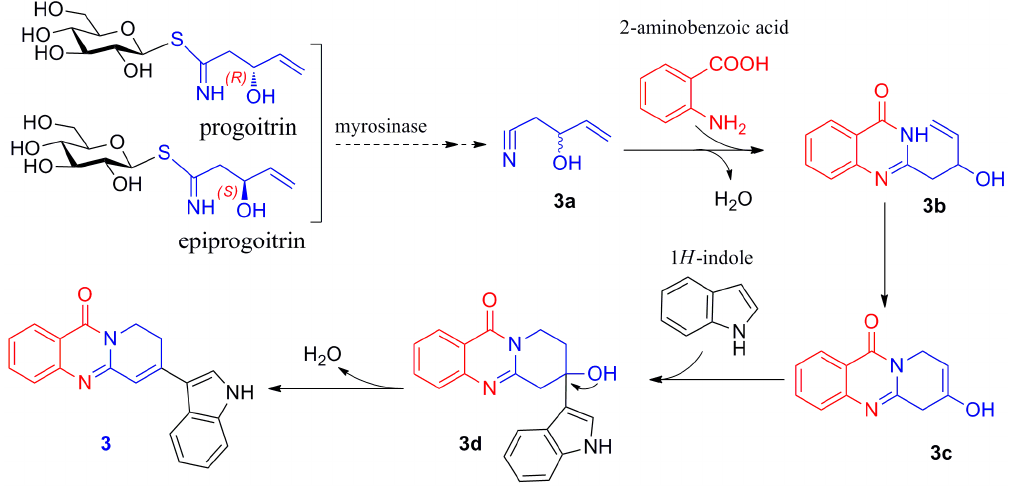
Figure 4. Putative biosynthetic pathway of 3.